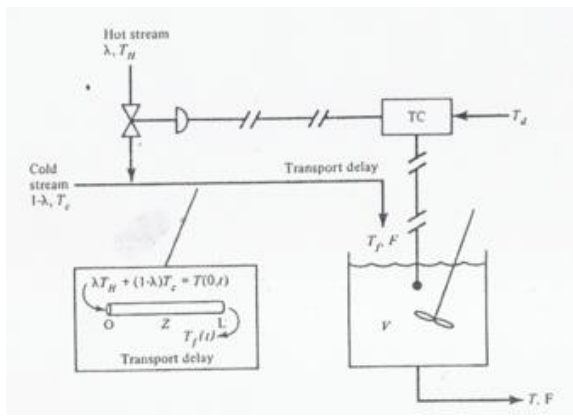
Figure 1. Control of the temperature in a stirred mixing tank with transport delays in the inlet piping The feed temperature at the mixing tank itself is denoted as T (t), and it is important to calculate temperature f T (t), in terms of the cold-steam temperature T f stream temperature T , and fraction of hot-stream feed H χ(t). The transport delay occurs due to fluid flowing at flow rate F in pipe of length L, and cross-sectional area a c